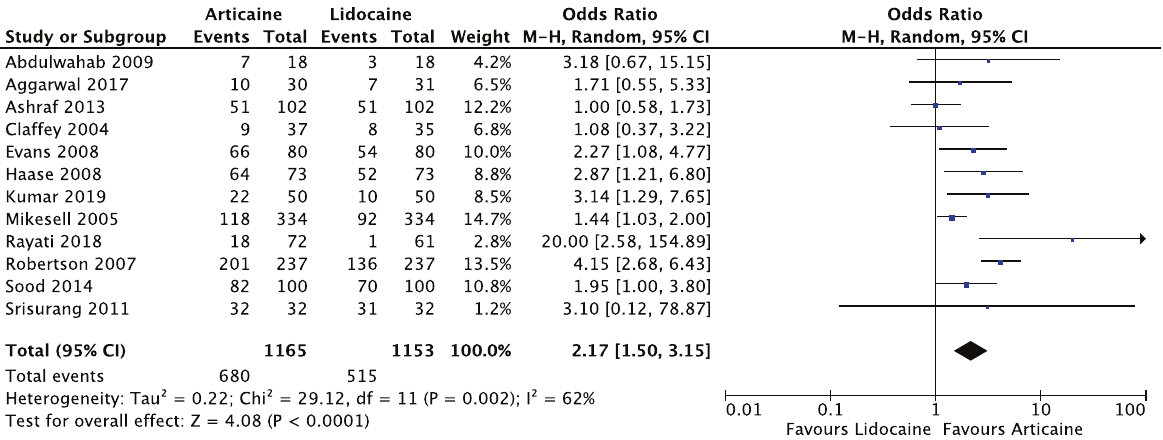
Fig. 5 Forest plot — all local anaesthetic interventions. Articaine had 2.17 times the likelihood of anaesthetic success of lidocaine.